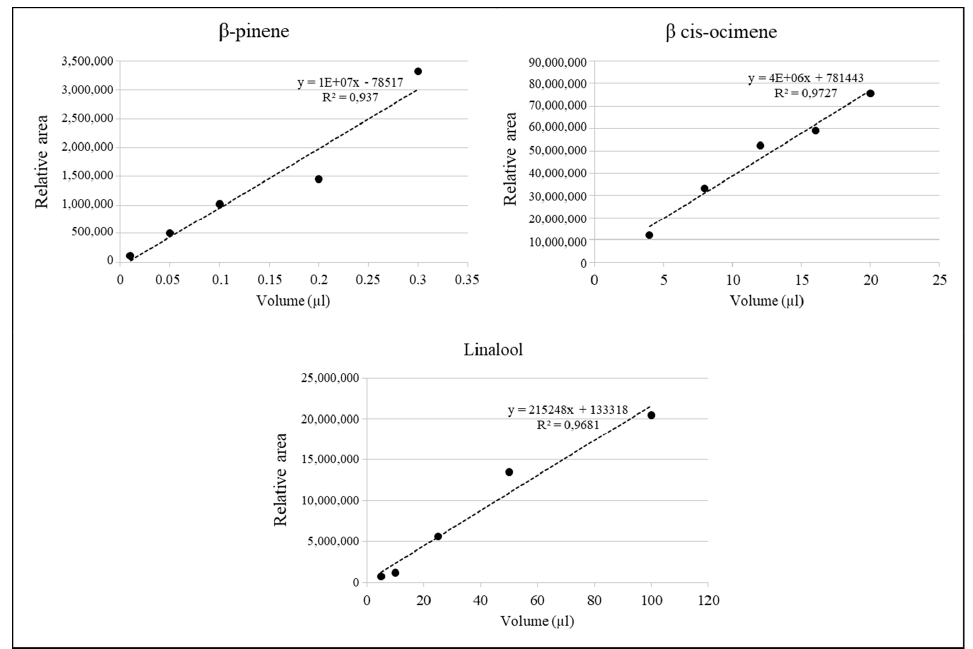
Figure A1. Calibration curves of the three major compounds detected in flowers of chrysanthemum, freesia, and oriental lily.